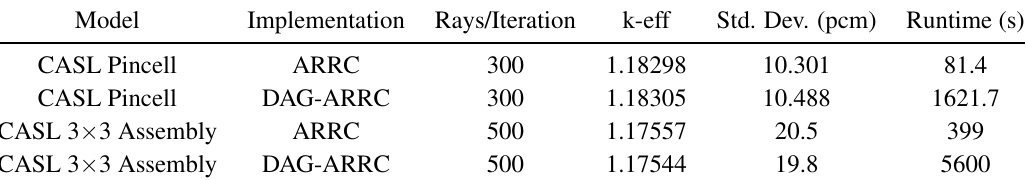
Table 1: Comparison of the initial application of DAGMC geometry (with each DAGMC volume representing a FSR in ARRC) to ARRC’s native CSG geometry using an Intel i7-8650U CPU with one thread. The simulated pincell is based on the CASL VERA Core Physics Benchmark Problem number 1A [11]. The 3x3 assembly problem includes 20 cm axial reflector regions above and below the fuel